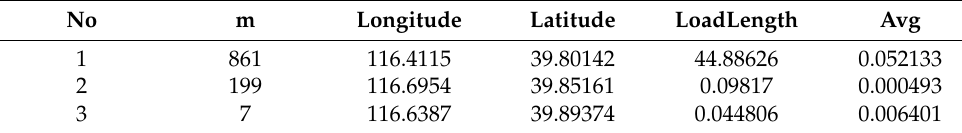
Table 13. The clustering results of PS_DBSCAN for the DS2 dataset.